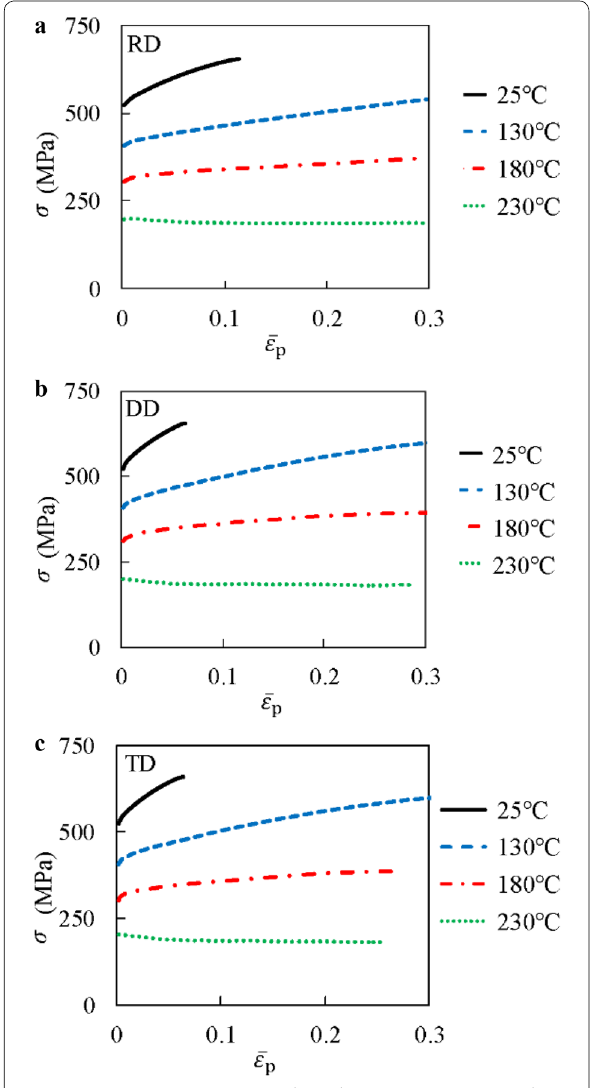
Figure 7 True stress ( σ ) vs. equivalent plastic strain ( ε p ) curves along (a) RD, (b) DD and (c) TD at elevated